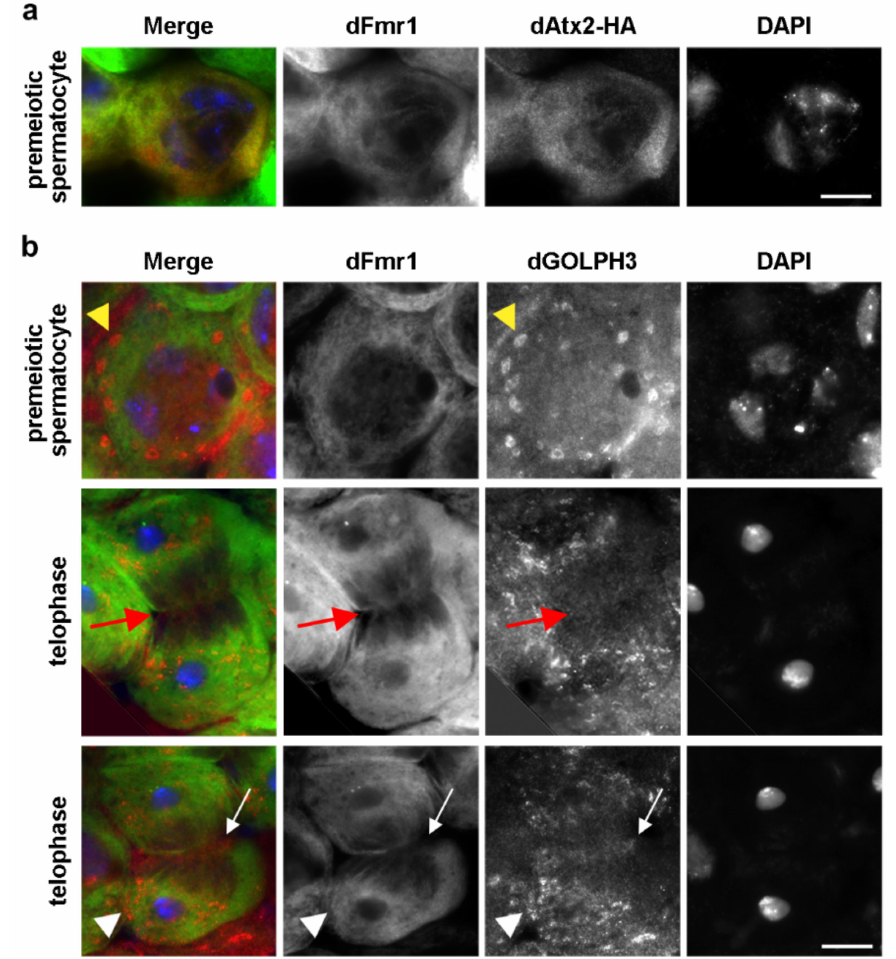
Figure 7. dFmr1 localization in premeiotic and dividing spermatocytes. ( a ) dFmr1 co-localizes with dAtx2 in the cytoplasm of primary spermatocytes. Testes expressing dAtx2-HA were stained for dFmr1(green), HA (dAtx2, red) and DNA (DAPI, blue). n = 40 spermatocytes randomly selected from images taken in five independent experiments. ( b ) Premeiotic and dividing spermatocytes were stained for dFmr1 (green) dGOLPH3 (red) and DNA (DAPI, blue). dFmr1 localizes to the cytoplasm of premeiotic spermatocytes and concentrates at the midzone (arrows) and at the astral membranes (arrowheads) at each pole of dividing spermatocytes (telophase). dGOLPH3 protein is visible in the cytoplasm and enriched in the Golgi stacks of premeiotic spermatocytes (yellow arrowheads). During telophase dGOLPH3 protein localizes to the midzone (arrows) and is enriched in puncta at the astral membranes of dividing spermatocytes (arrowheads). n = 40 premeiotic spermatocytes and n = 25 telophase spermatocytes, randomly selected from images taken in five independent experiments. Bars, 10 µ